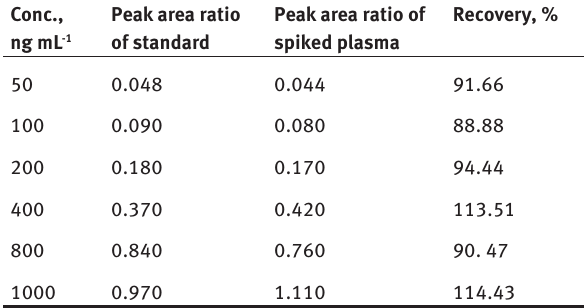
Table 1: Extraction % recovery of lixivaptan from spiked mouse plasma using solvent deproteinization procedure.